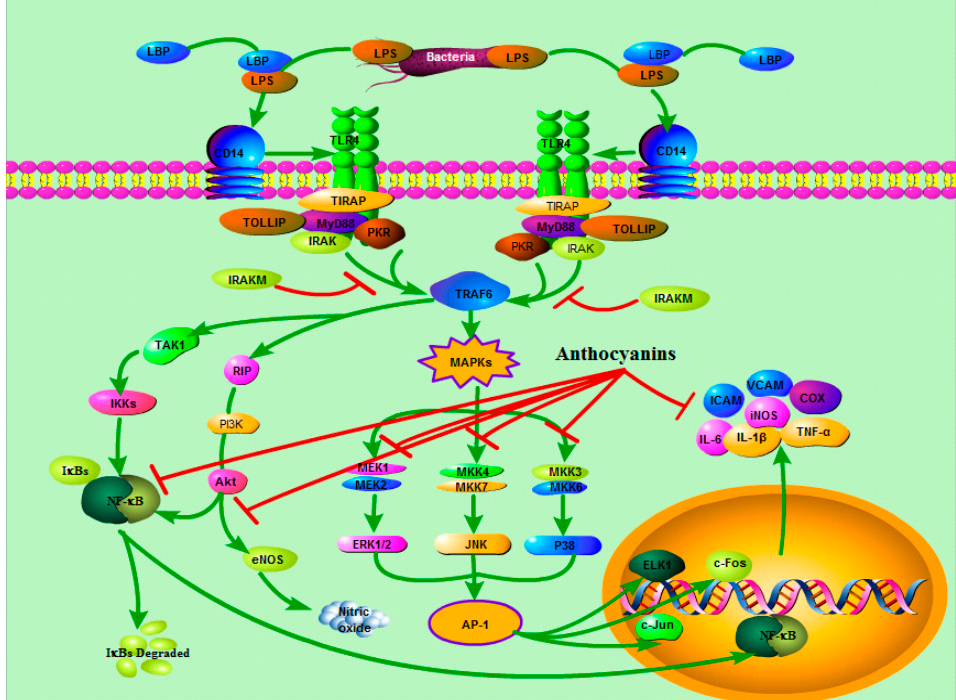
Figure 3. Anthocyanins inhibit TLR4 protein expression and MAPKs signaling pathway. The structure of TLR4 is divided into three domains: extracellular domain, transmembrane domain, and intracellular domain. Extracellular LPS binds to CD14, and since CD14 does not have a transmembrane domain, it binds to the extracellular domain of TLR4 to a transmembrane-mediated endotoxin. When the signal was transferred into the cell, the MyD88 adaptor protein and toll–irak complex began to be recruited. The intracellular TIR region of TLR4 binds to the carboxyl end of MyD88, and the amino terminal of MyD88 binds to IRAK again to activate IRAK (IRAK-M, as a negative regulator, can inhibit the phosphorylation of IRAK and interrupt signal transduction). Activated IRAK reactivates TRAF-6 and further activates the NF- κ B, MAPKs, and PI3K-Akt signaling pathways, promoting the secretion of NO and inflammatory factors (Ding et al., 2018; Monica et al., 2016).